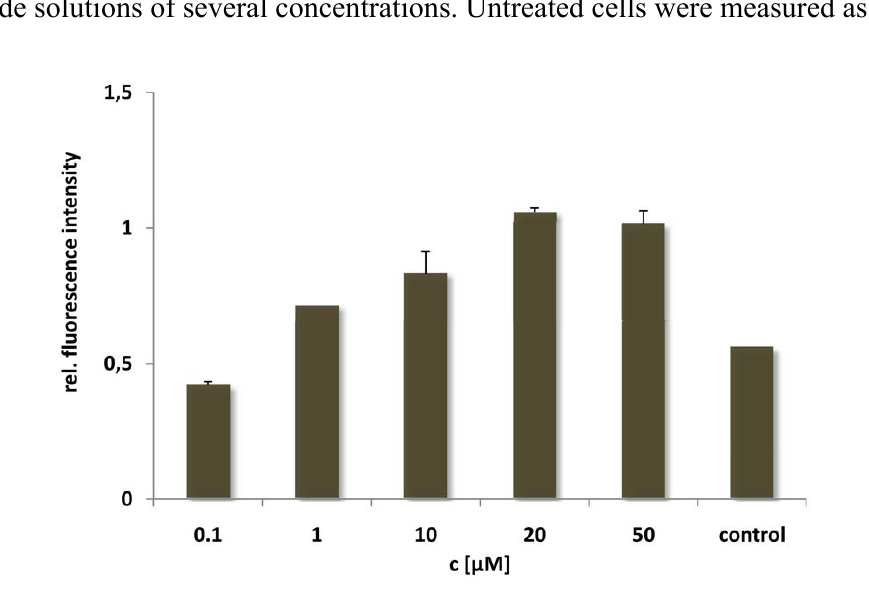
Figure 4. Cellular uptake of CF-labelled N-E5L after incubating HeLa cells for 60 min with peptide solutions of several concentrations. Untreated cells were measured as control.